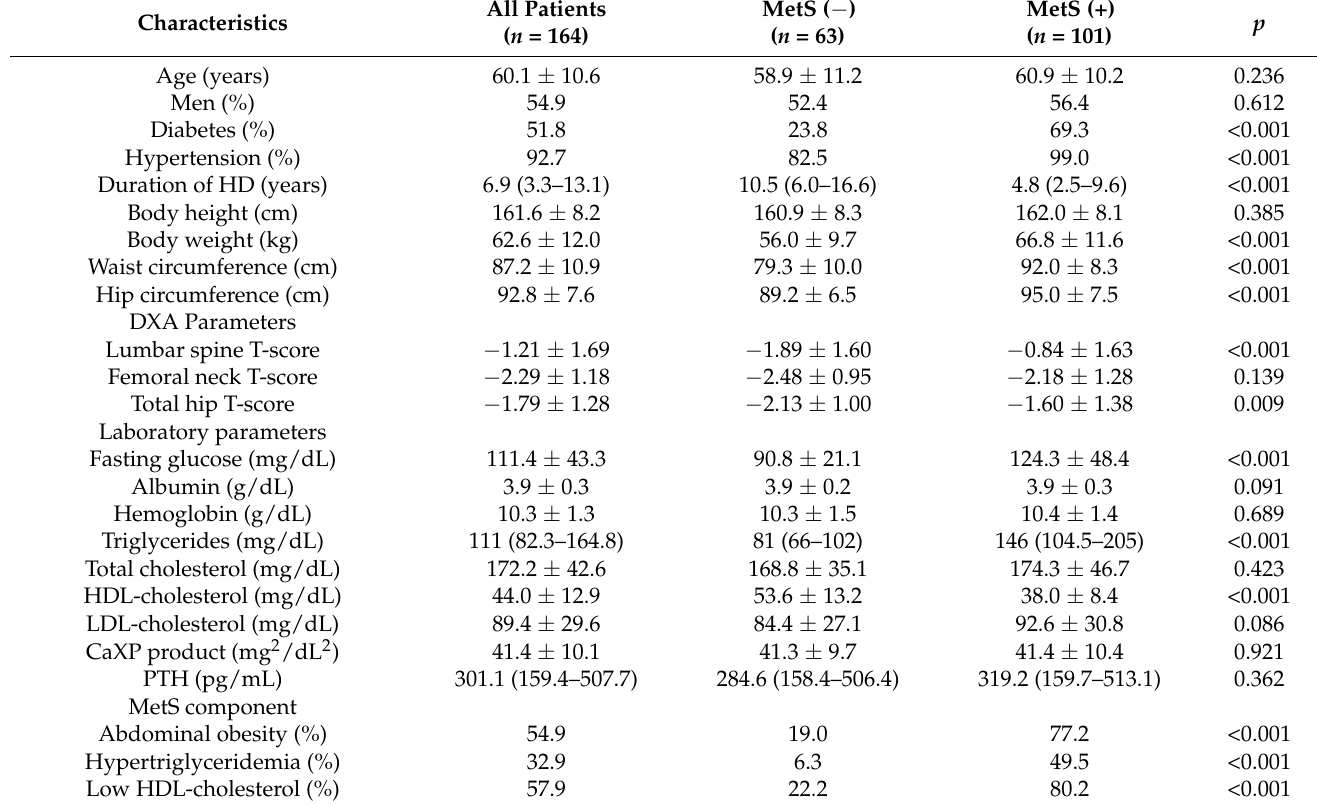
Table 1. Comparison of baseline characteristics among chronic HD patients stratified by MetS status.